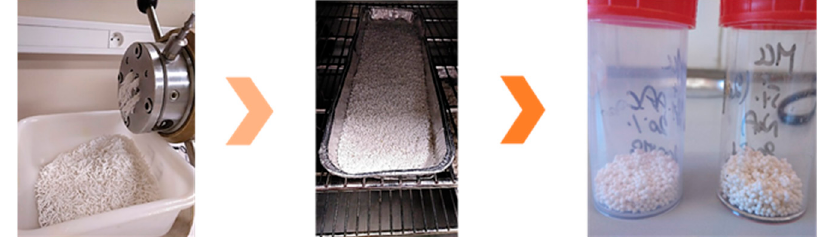
Image 1. Extrusion-spheronization techniques with pine essential oil ( α -pinene 26% and limonene 19%)